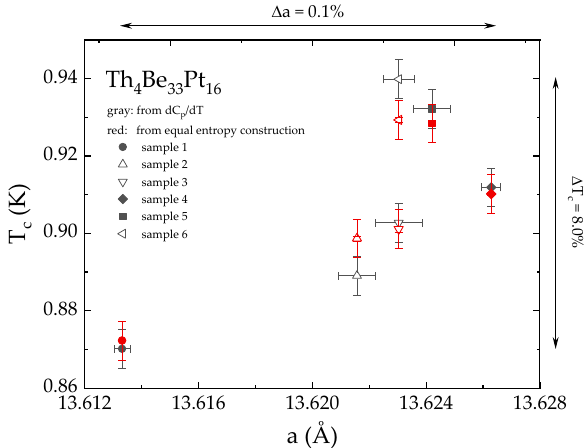
Figure 2. Relationship between crystallinity and superconducting properties of Th 4 Be 33 Pt 16 . The critical temperature T c versus the lattice parameter a for six Th 4 Be 33 Pt 16 samples. The values of T c were taken from the equal entropy construction (red symbols) and as the minimum in the first derivative of the specific heat data (gray symbols). The variation of a is two orders of magnitude less, compared to the corresponding variation of T c .